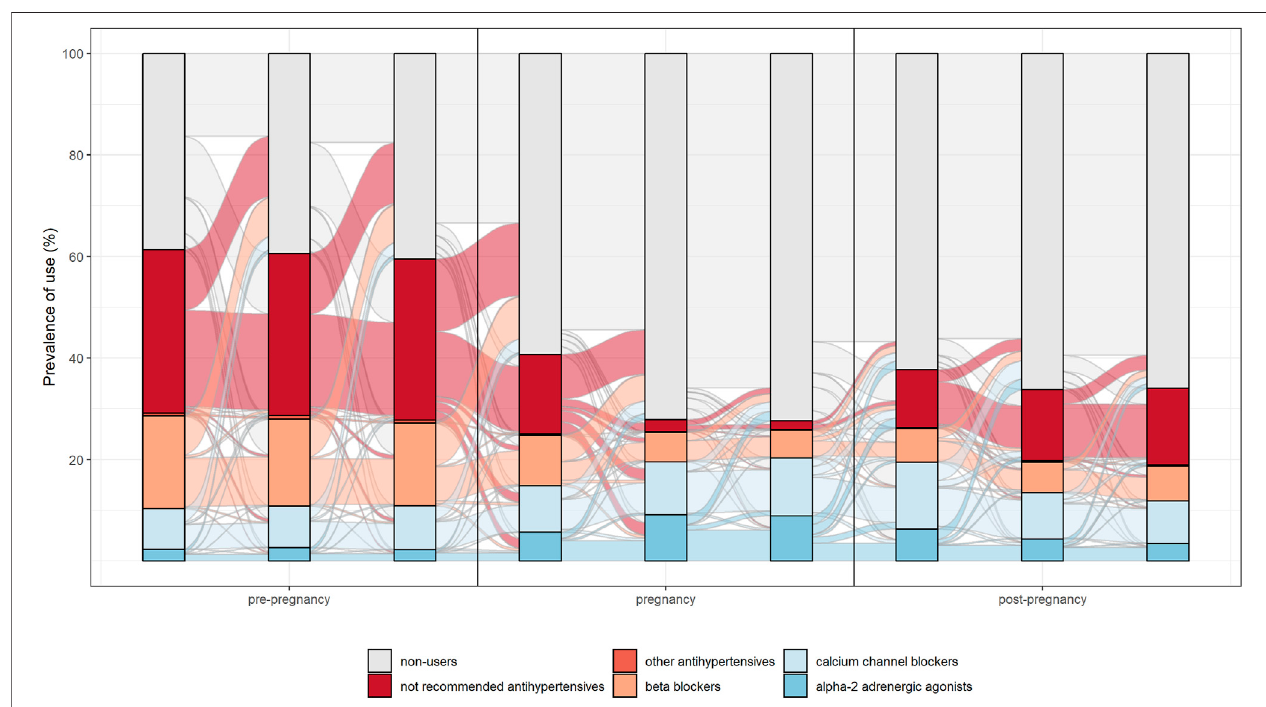
FIGURE2| Sankey diagramusedtodescribethepattern ofdruguseindifferenttrimestersofpregnancy: theexampleofantihypertensiveinwomenwithprevalent use during pregnancy.